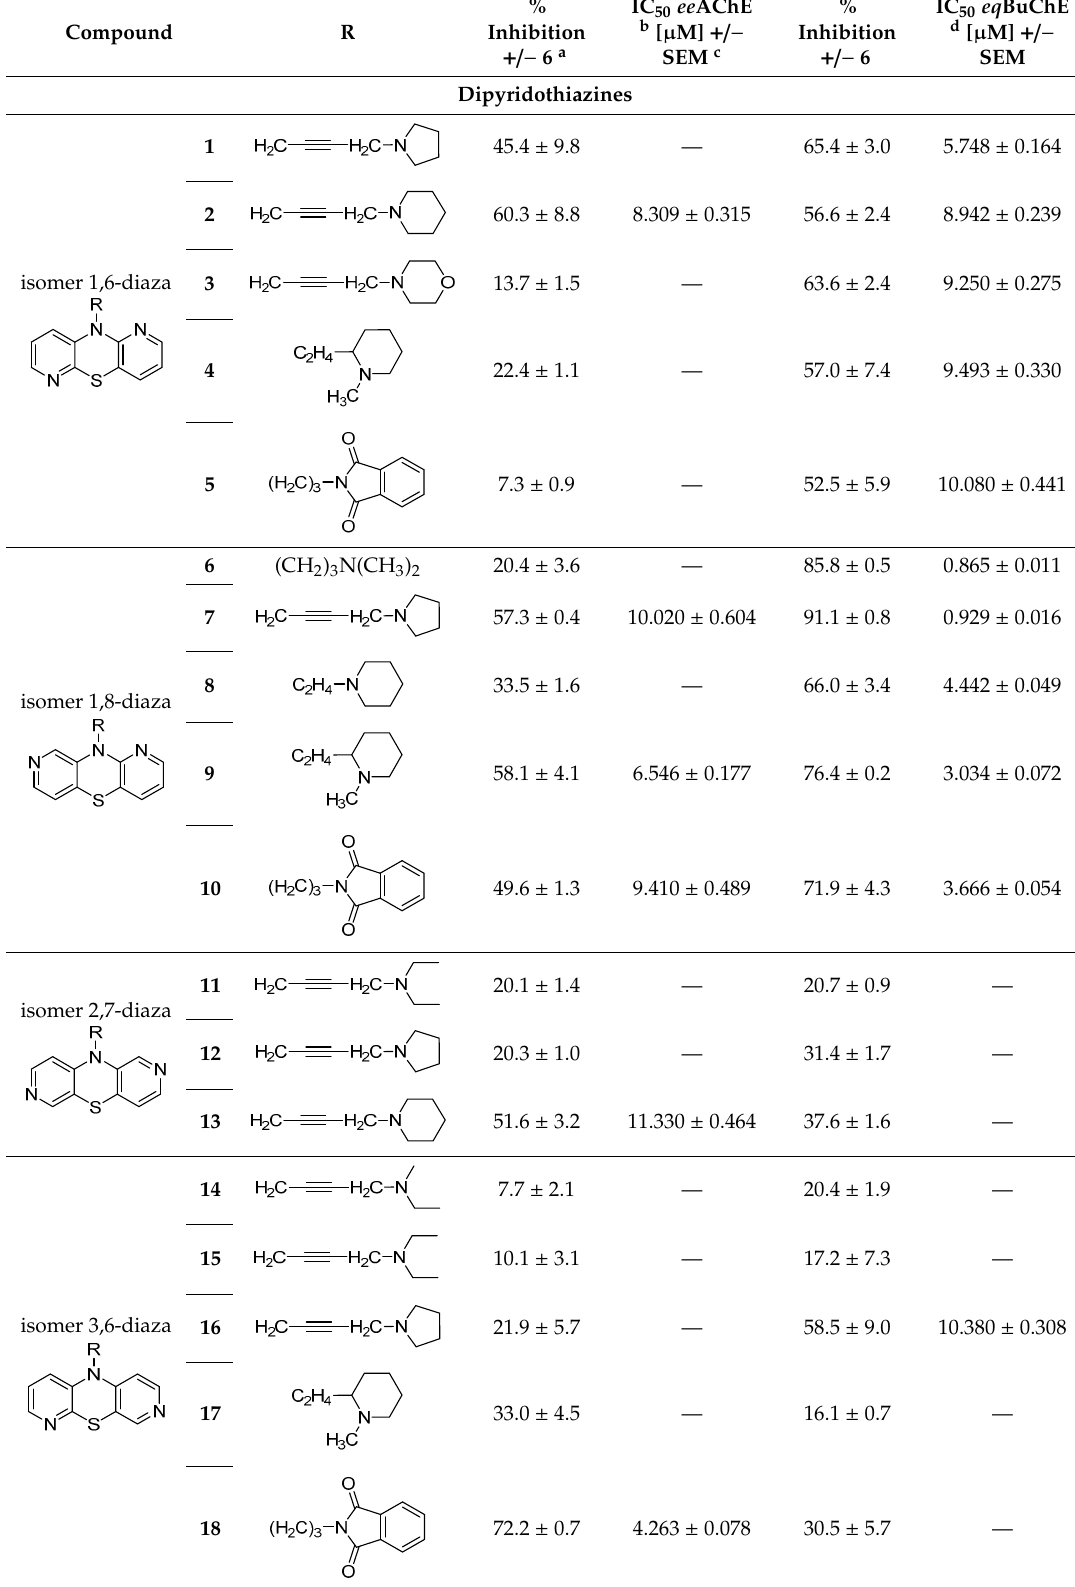
Table 1. Inhibition of AChE and BuChE by polycyclic compounds selected by virtual in silico screening. Compound Molecules 2020 , 25 ,